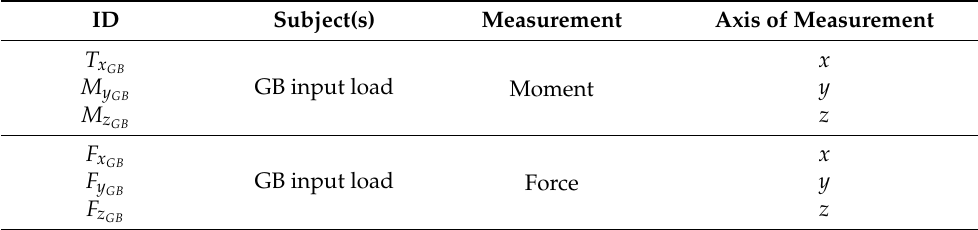
Table 1. Estimated loads and their respective